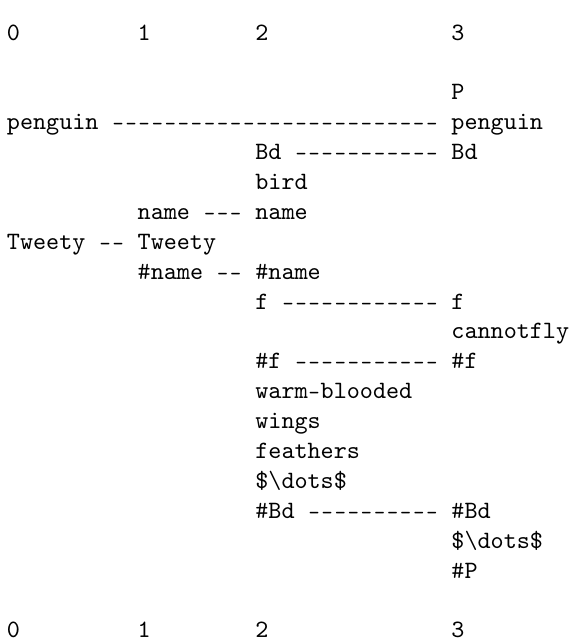
Figure 9. The best SPMA formed by the SPCM with the New SP-pattern ‘penguin Tweety’ and with SP-patterns in Old as described in the text. The relative probability of this SPMA is 1.0. Reproduced from ([2], Figure